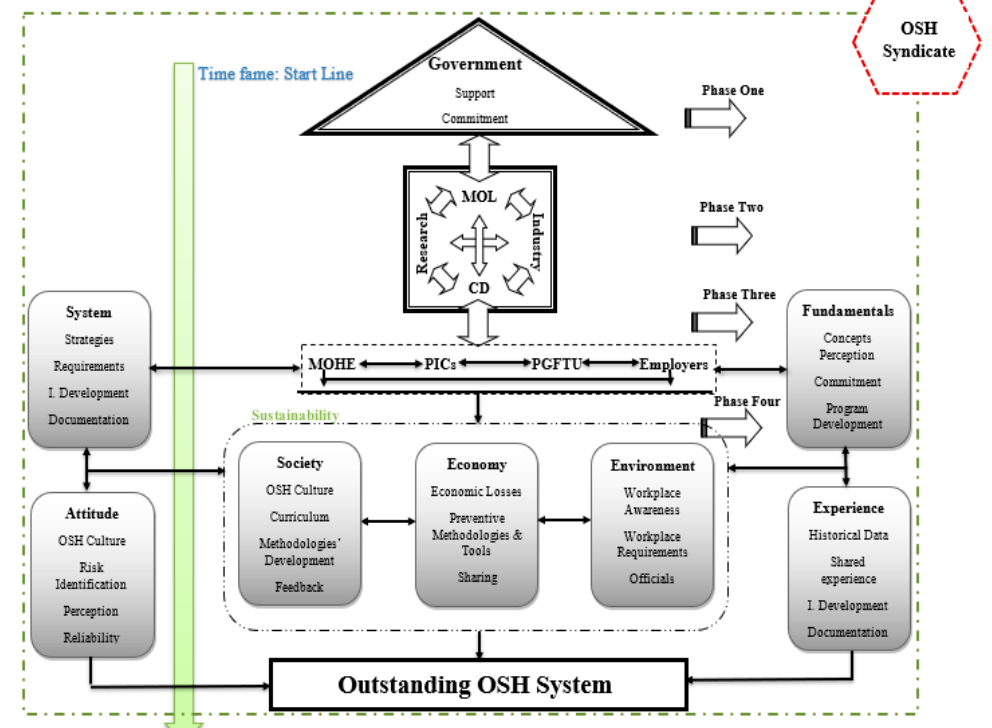
Figure 26. OSH outstanding conceptual framework.